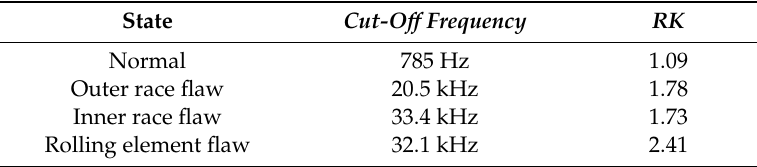
Table 5. Optimum cuto ff frequency and RK (verification step).